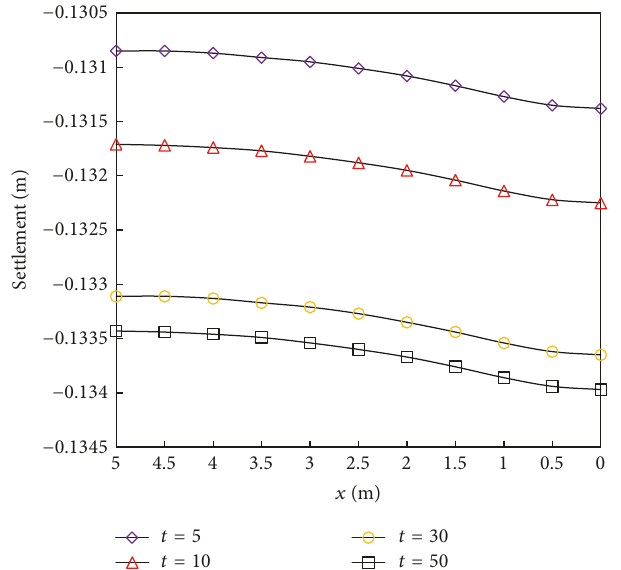
Figure 6: The surface settlement at the boundary 0B with infiltration